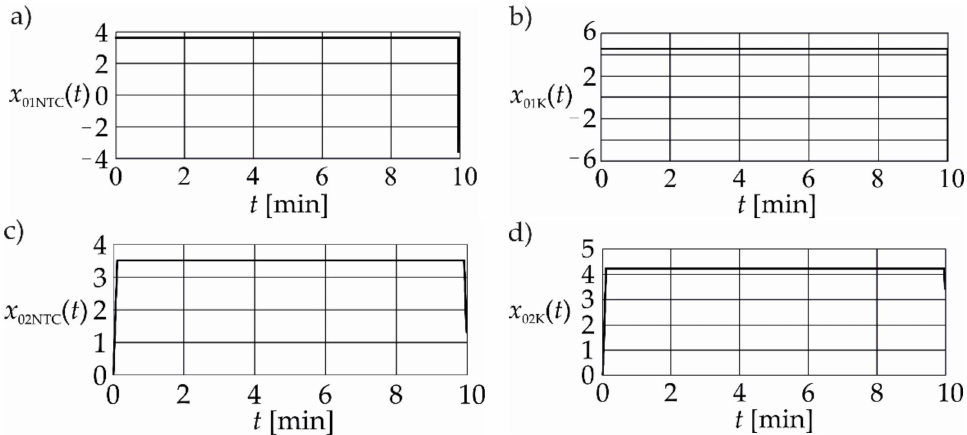
Figure 7. Signals x 01 ( t ) and x 02 ( t ) for the negative temperature coefficient (NTC) ( a , c ) and K-type thermocouple ( b , d )